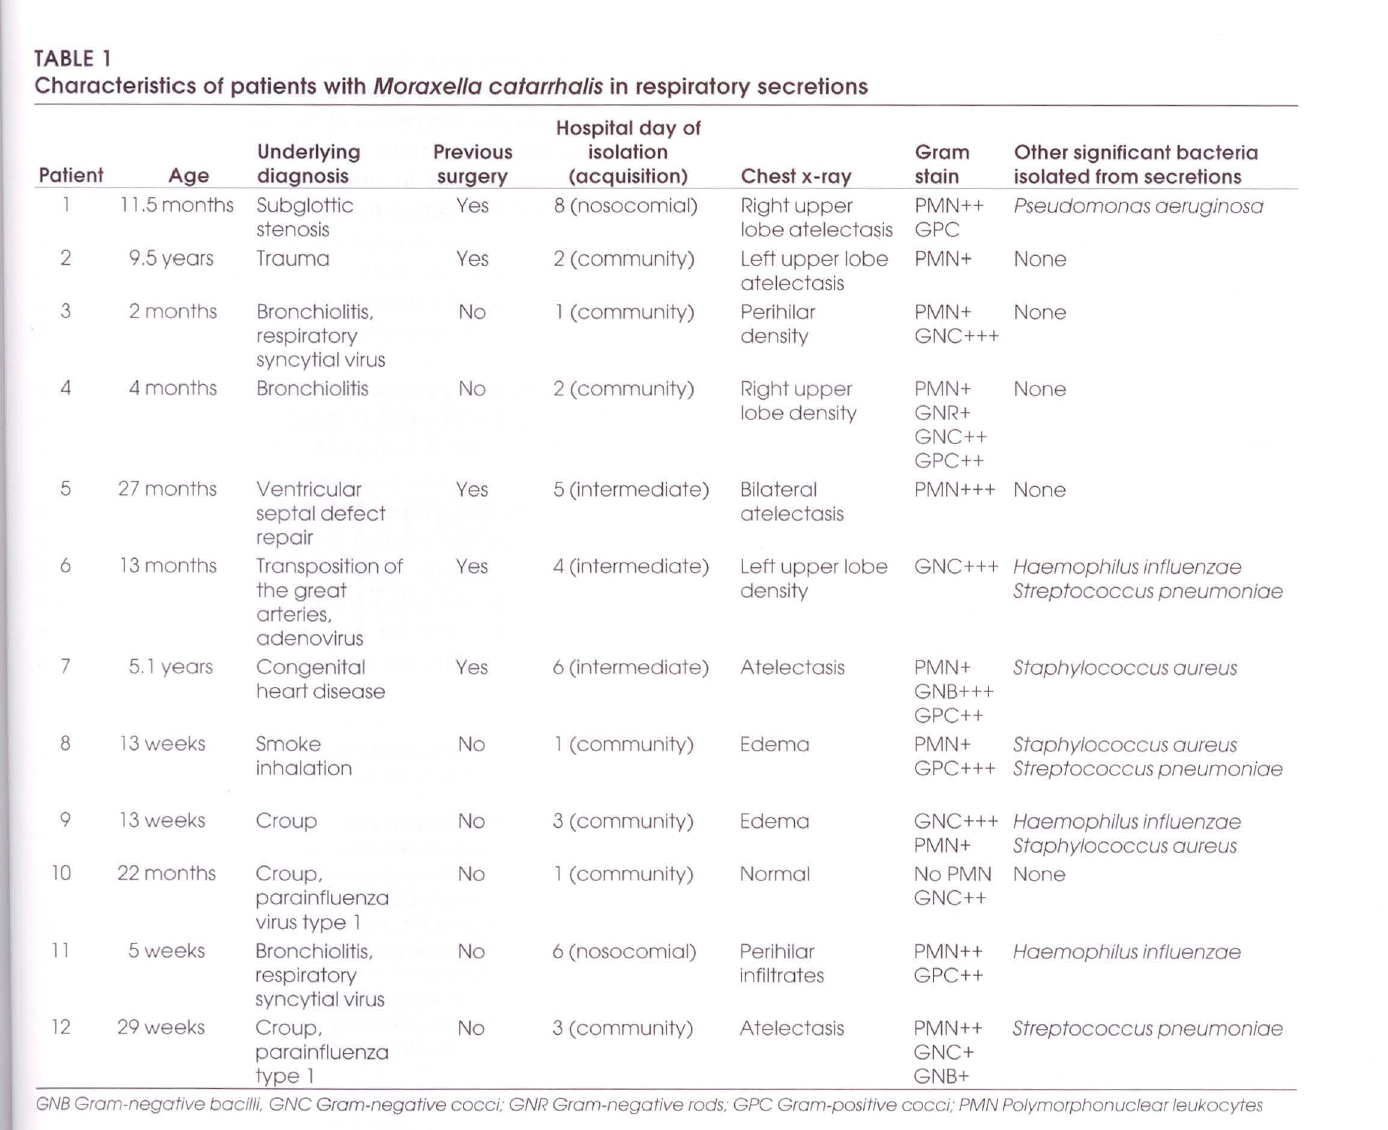
Hospital day of